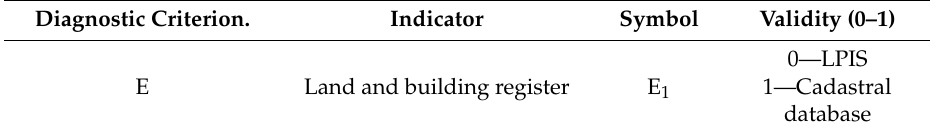
Table 6. Sources of Data for Databases of Cadastral Parcels and Buildings. LPIS: Land Parcel Identification